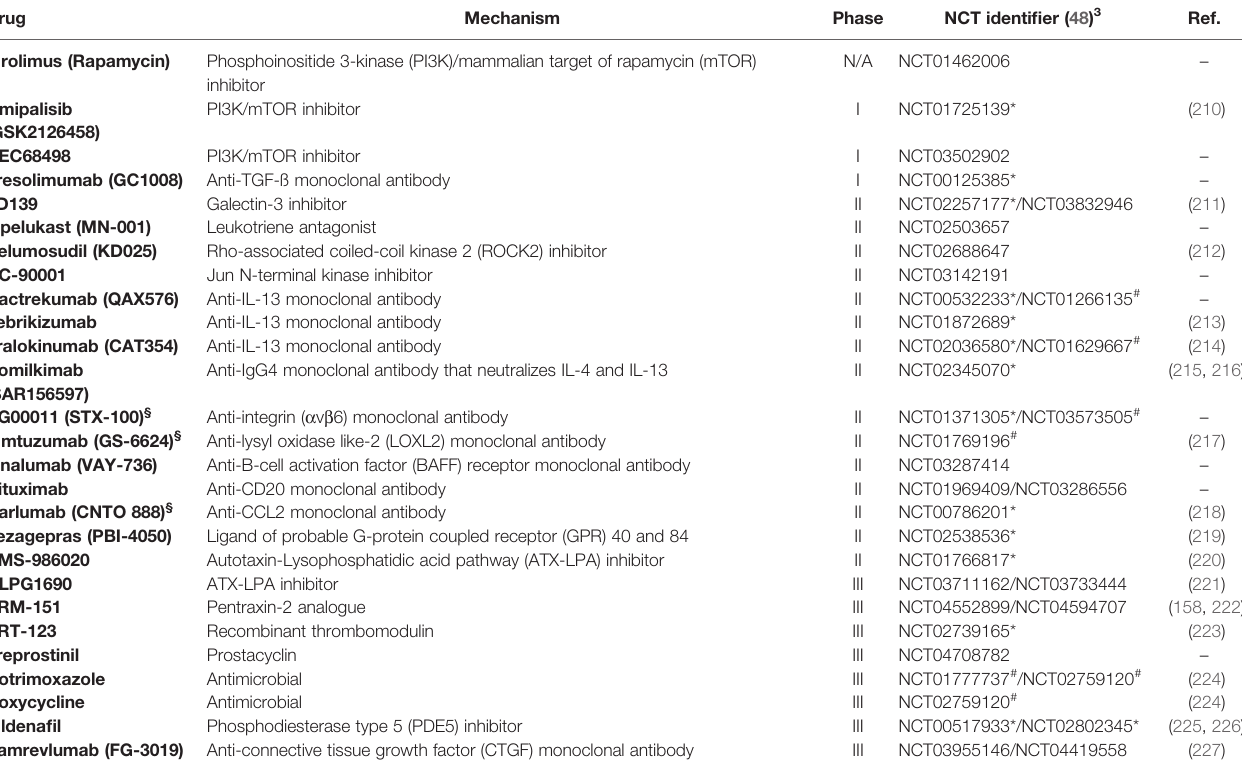
TABLE 1 | Last completed and/or ongoing clinical trials in idiopathic pulmonary fi